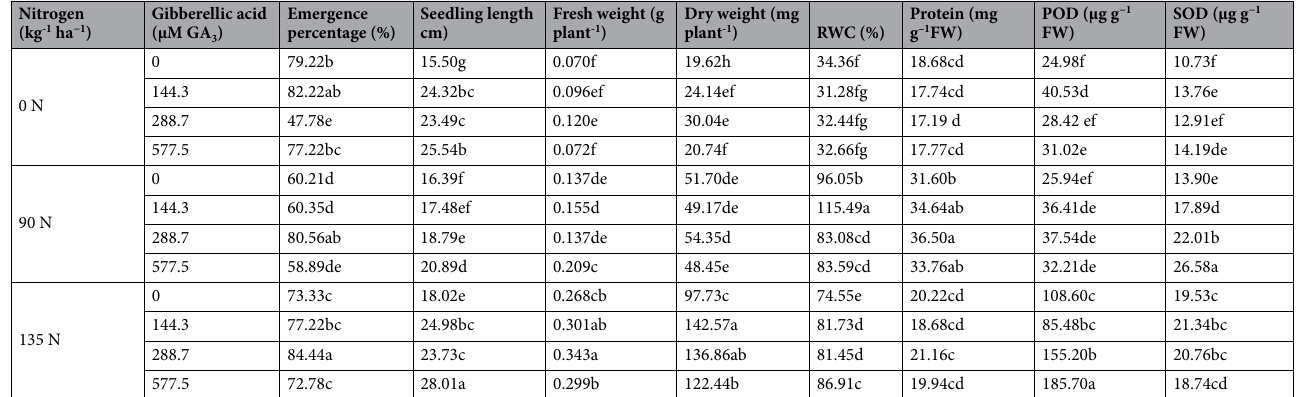
Table 3. Effects of different nitrogen rates and different gibberellic acid (GA 3 ) levels on emergence percentage, seedling length, fresh weight, dry weight, relative water content (RWC) protein content (mg g –1 FW), SOD, and POD of sorghum seedlings. Different letters in the same column show significant differences at the 0.05 probability